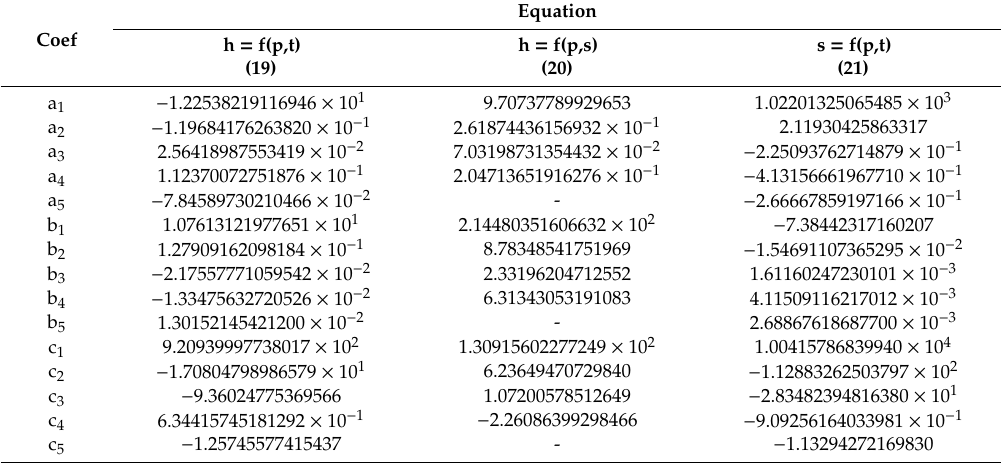
Table 8. Coe ffi cients of polynomials describing the properties of the R1234ze(E) refrigerant in the superheated vapour state (h = f(p,t), h = f(p,s), s = f(p,t)).